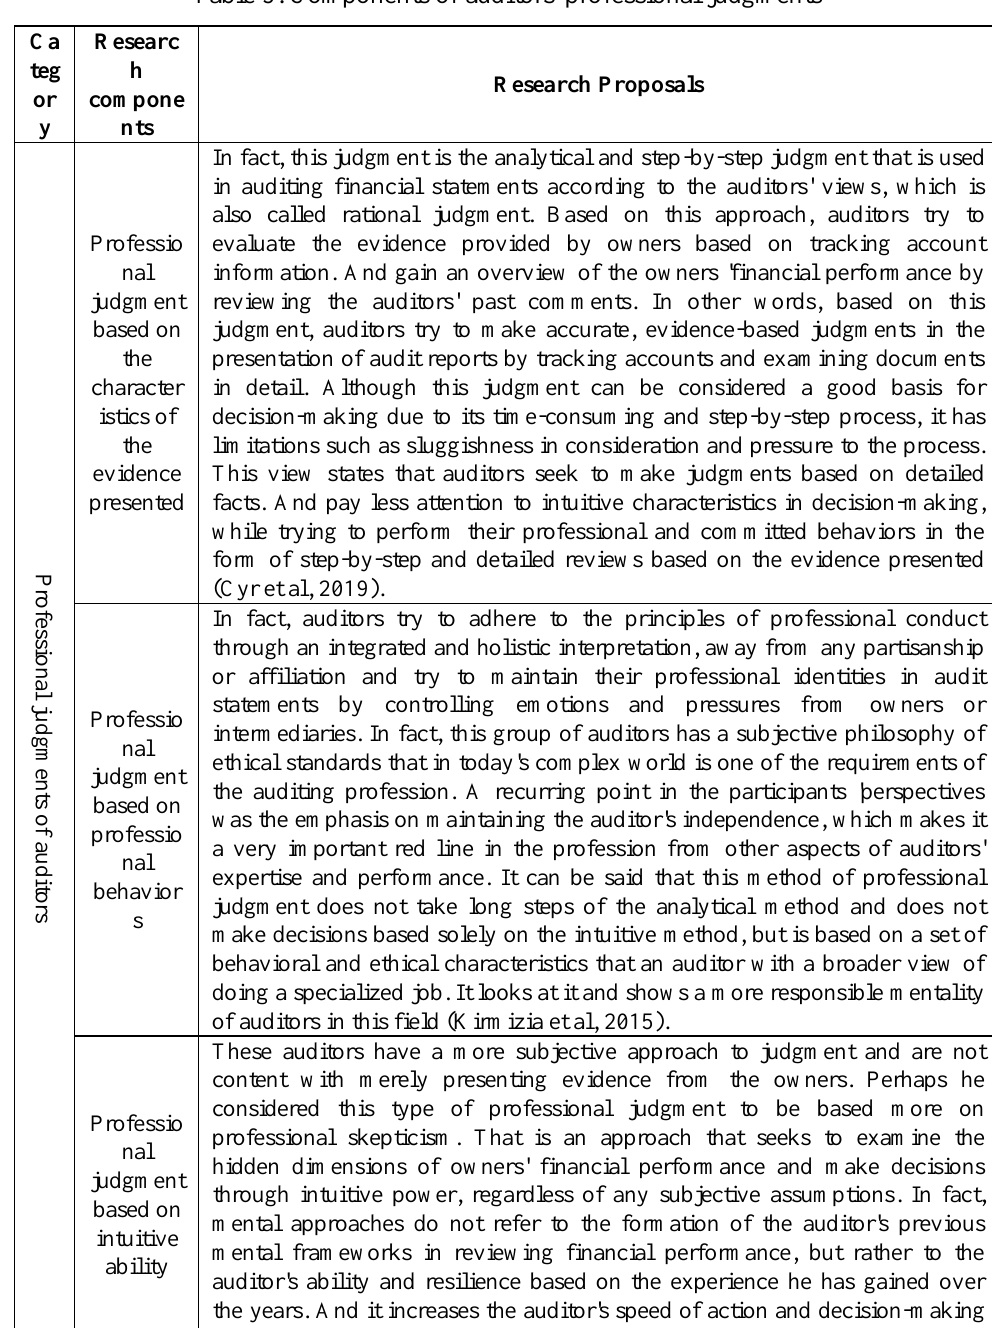
Table 3. Components of auditors' professional